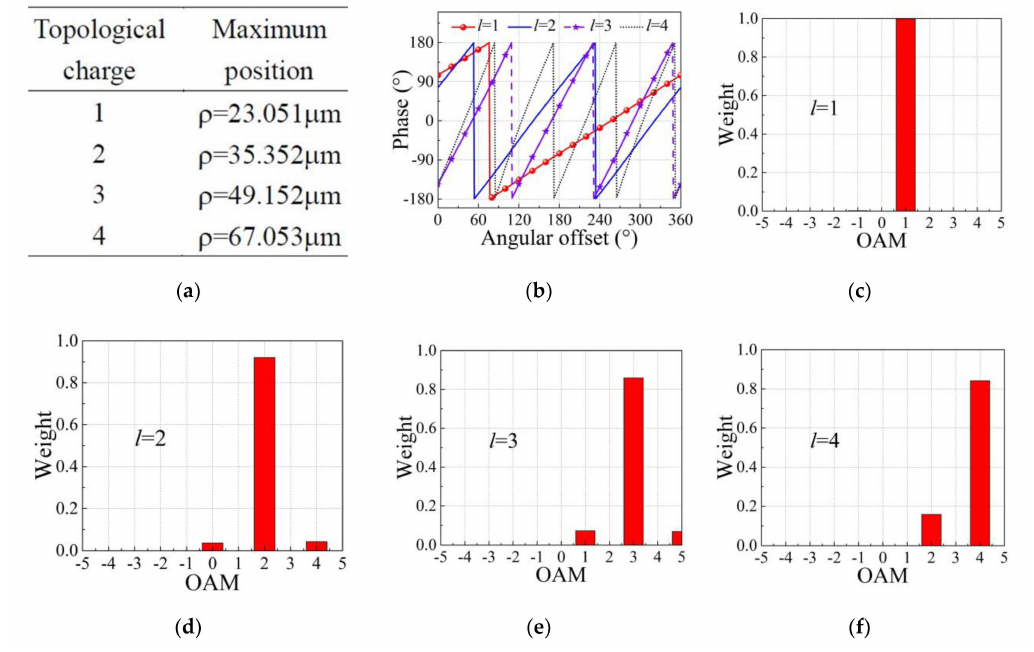
Figure 13. The same as in Figure 12, but here the scattered field is simulated. The radius of the illuminated particle is changed to 1.0 µ m and other parameters are